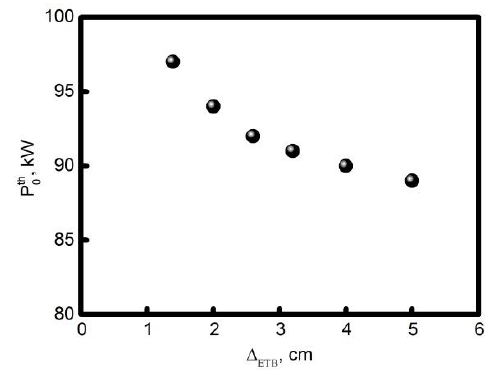
Fig. 5. Dependence of the instability threshold, which is determined numerically, on the inhomogeneity scale the density profile inflection point The other parameters are the same as in figure 2.